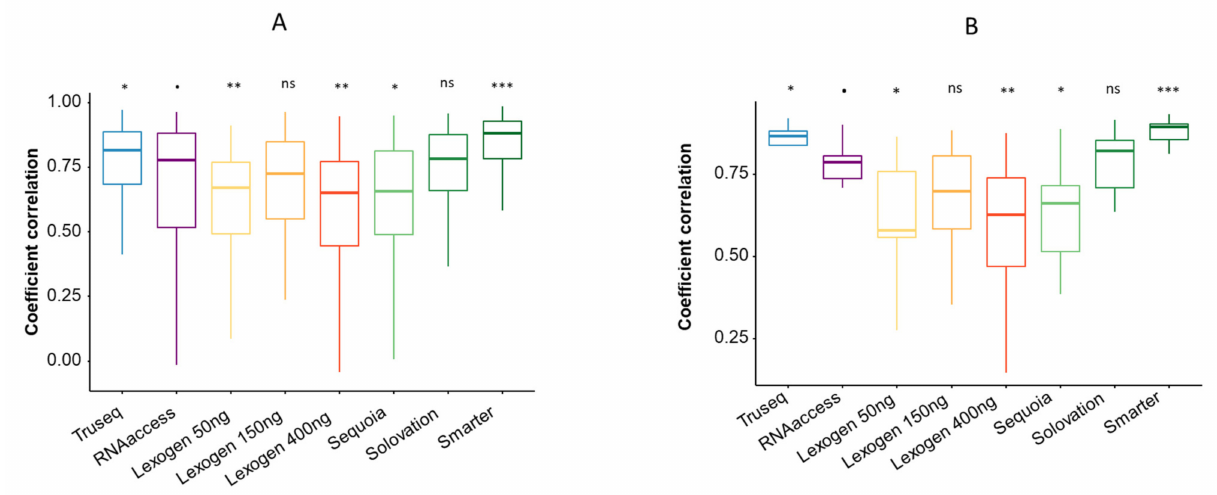
Figure 2. Comparison of sequencing kits with Nanostring. ( A ) Gene-wise correlation of gene expressions between Nanostring and other sequencing kits. The distribution of the correlation coefficients for each technique were compared using a Mann–Whitney test and using RNAAccess as a comparison. The lower and upper hinges correspond to the first and third quartiles. The upper whisker extends from the hinge to the largest value no further than 1.5 * interquartile range from the hinge. The lower whisker extends from the hinge to the smallest value at most 1.5 * interquartile range of the hinge. . : reference; *: p -value between 0.01 and 0.05. **: p -value between 0.001 and 0.01; ***: p -value < 0.001. ( B ) Sample-wise correlation between Nanostring and other sequencing kits. The distribution of the correlation coefficients for each technique were compared using a Mann–Whitney test and using RNAAccess as a comparison. The lower and upper hinges correspond to the first and third quartiles. The upper whisker extends from the hinge to the largest value no further than 1.5 * interquartile range from the hinge. The lower whisker extends from the hinge to the smallest value at most 1.5 * interquartile range of the hinge. . : reference; *: p -value between 0.01 and 0.05. **: p -value between 0.001 and 0.01; ***: p -value <